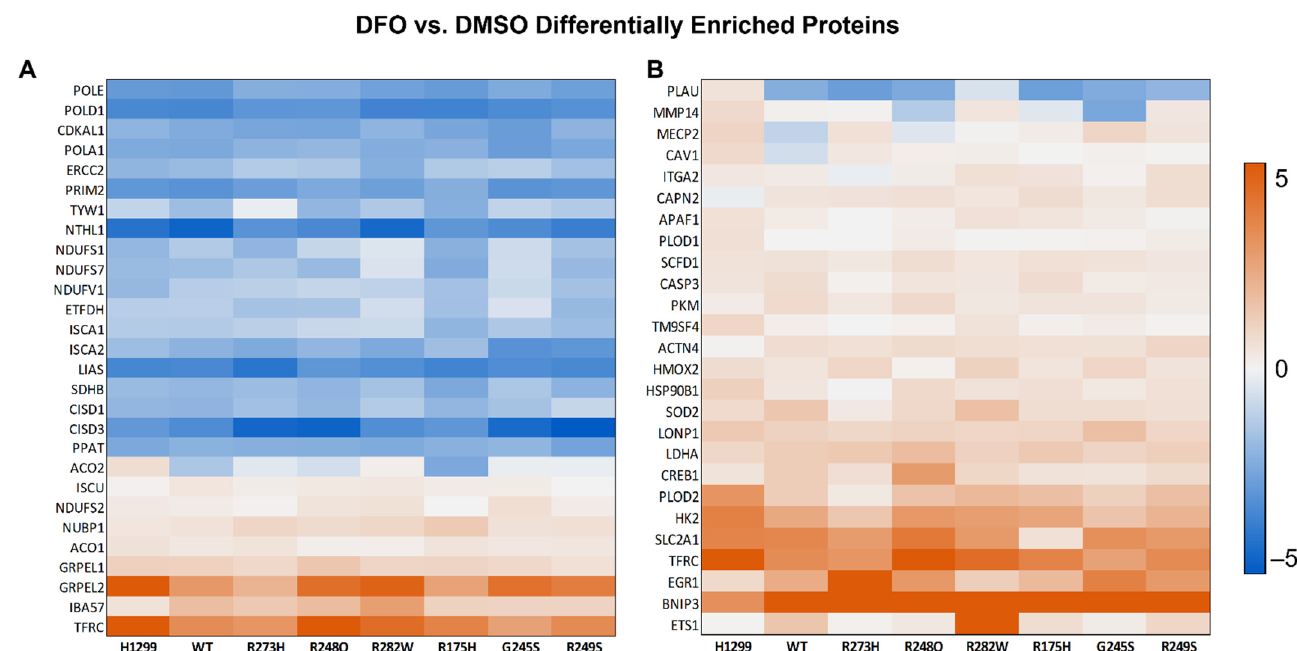
Figure 4. Cells expressing distinct TP53 mutation types exhibit similar protein expression pattern changes in response to iron restriction. ( A ) Differential protein expression summary for proteins with annotated functions in Fe-S cluster biogenesis and ( B ) the cellular response to hypoxia from cells described in Figure 1. Legend scale is the ratio of the log 2 fold-change (DFO/DMSO).